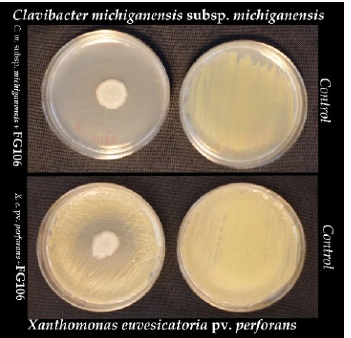
Figure 2. Antagonistic effects of P. aeruginosa strain FG106 against Clavibacter michiganensis subsp. michiganensis and Xanthomonas euvesicatoria pv. perforans in vitro.